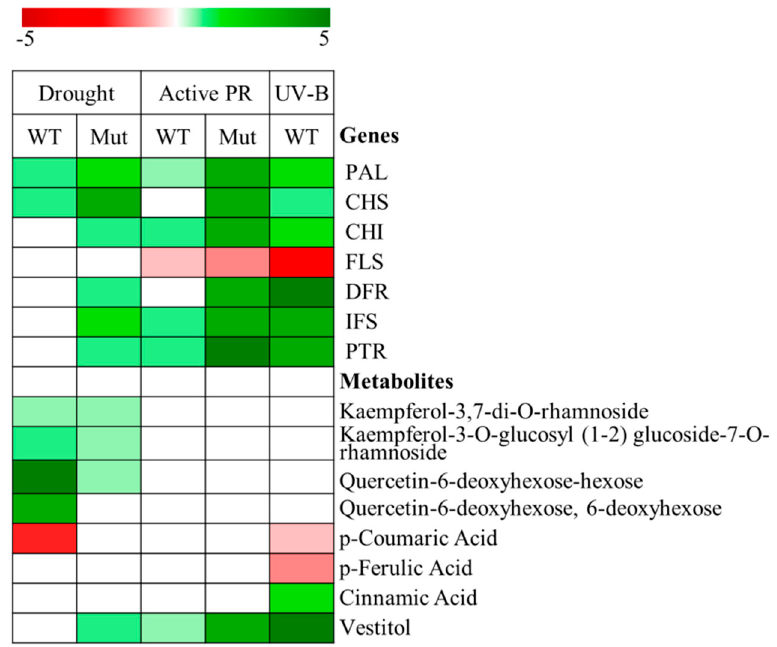
Figure 2. Comparison of the changes in the relative expression levels of the most highly modulated genes (determined by RT-qPCR) and in the levels of metabolites in Lotus japonicus leaves, in response to different abiotic stress situations studied (drought, impairment of photorespiration, UV-B irradiation). Changes are indicated as log 2 of the fold change in gene expression levels and metabolite content for each genotype and stress condition analyzed, relative to the unstressed control plants, as described in previous works [42,62]. Red and green indicate lower and higher levels than in the controls, respectively. The color intensity represents the log 2 of fold change as indicated in the scale bar. WT, wild type; MUT, Ljgln2-2 photorespiratory mutant plants deficient in plastidic glutamine synthetase (GS2); active PR, active photorespiration. Active photorespiration is particularly stressful for the Ljgln2-2 mutant plants due to the high accumulation of ammonium produced as a consequence of the deficiency in photorespiratory ammonium re-assimilation (the impairment of photorespiration) [95,98]. Abbreviations used for genes are described in Figure 1. Given the high number of genes that encode for the flavonoid and isoflavonoid biosynthetic enzymes and the high gene redundancy, a set of specific oligonucleotides were utilized that amplified only specific copies of the redundant gene probesets for key enzymes of the pathways [62]. The results obtained for the most representative and highly expressed gene from each gene family are shown. Genes indicated have the following accession numbers (using Kazusa 3.0 terminology and when available GeneBank codes): PAL, Lj1g3v4590760 (BAF36971.1); CHS, Lj2g3v2124310; CHI, Lj5g3v2288880 (Q8H0G2.1); FLS, Lj1g3v0705350; DFR, Lj5g3v0108500 (BAE19948.1); IFS, Lj4g3v0485090 (BAF64284.1); PTR, Lj3g3v3360890 (BAF34841.1). Semi-systematic names and chemical structures of the indicated metabolites are shown in Table S1.